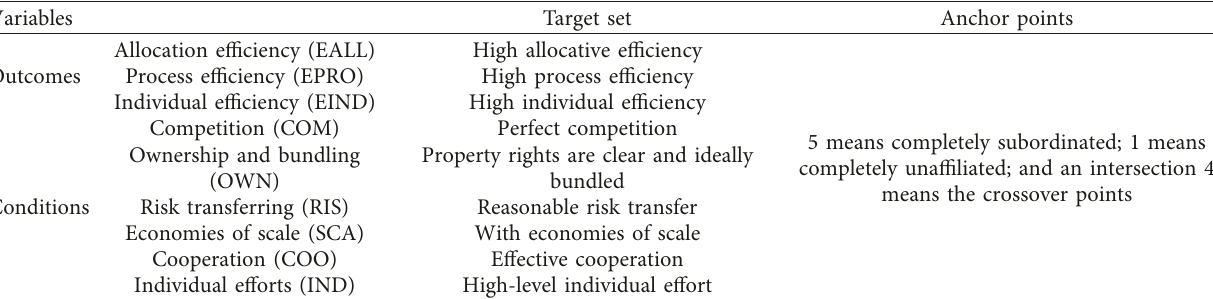
Table 4: Calibration